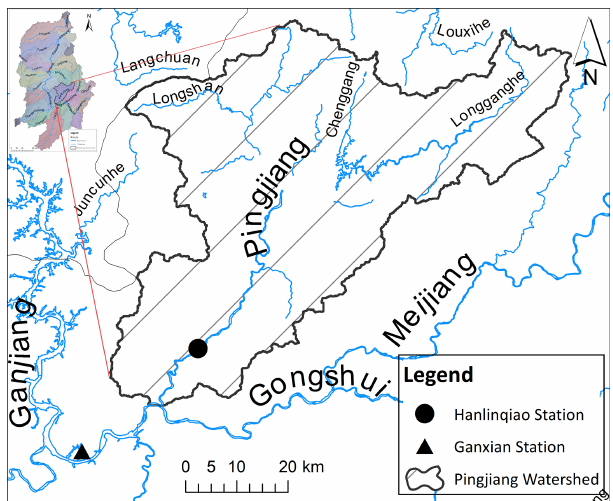
Figure 5. Location of Ganxian meteorological station and Hanlin- qiao hydrological observation